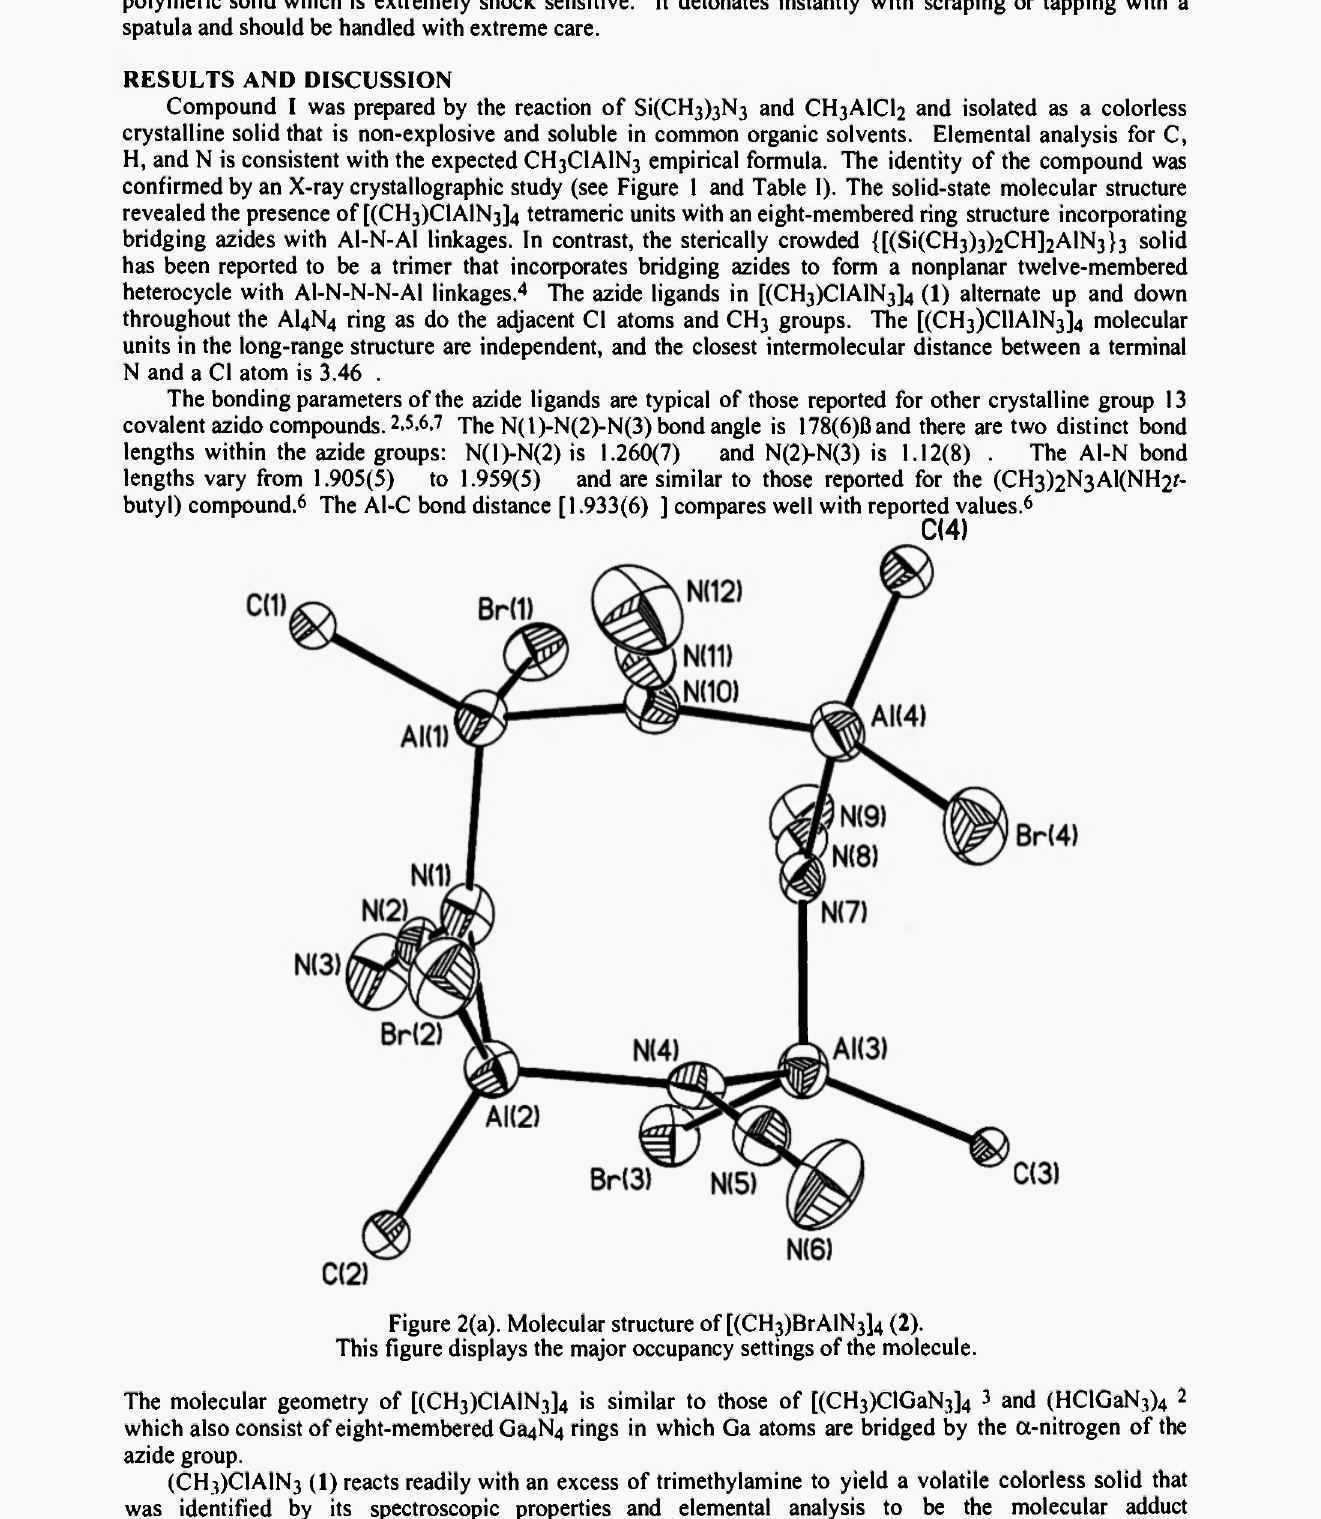
Figure 2(a). Molecular structure of [(CH^BrAl^k (2). This figure displays the major occupancy settings of the